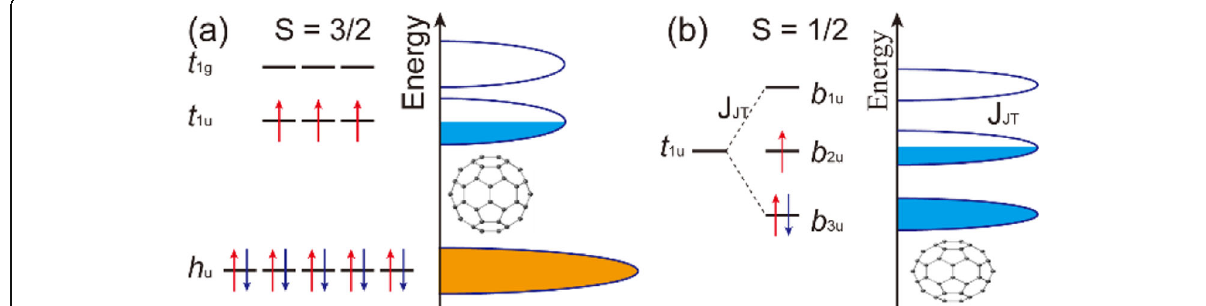
Fig. 1 Sketches of molecular orbital energy of C 603 − anions and simplified electronic structure of solid A 3 C 60 ( a ) with and ( b ) without JT effect. The JT distortion splits the triple degenerated t 1u orbital into b 1u , b 2u , and b 3u